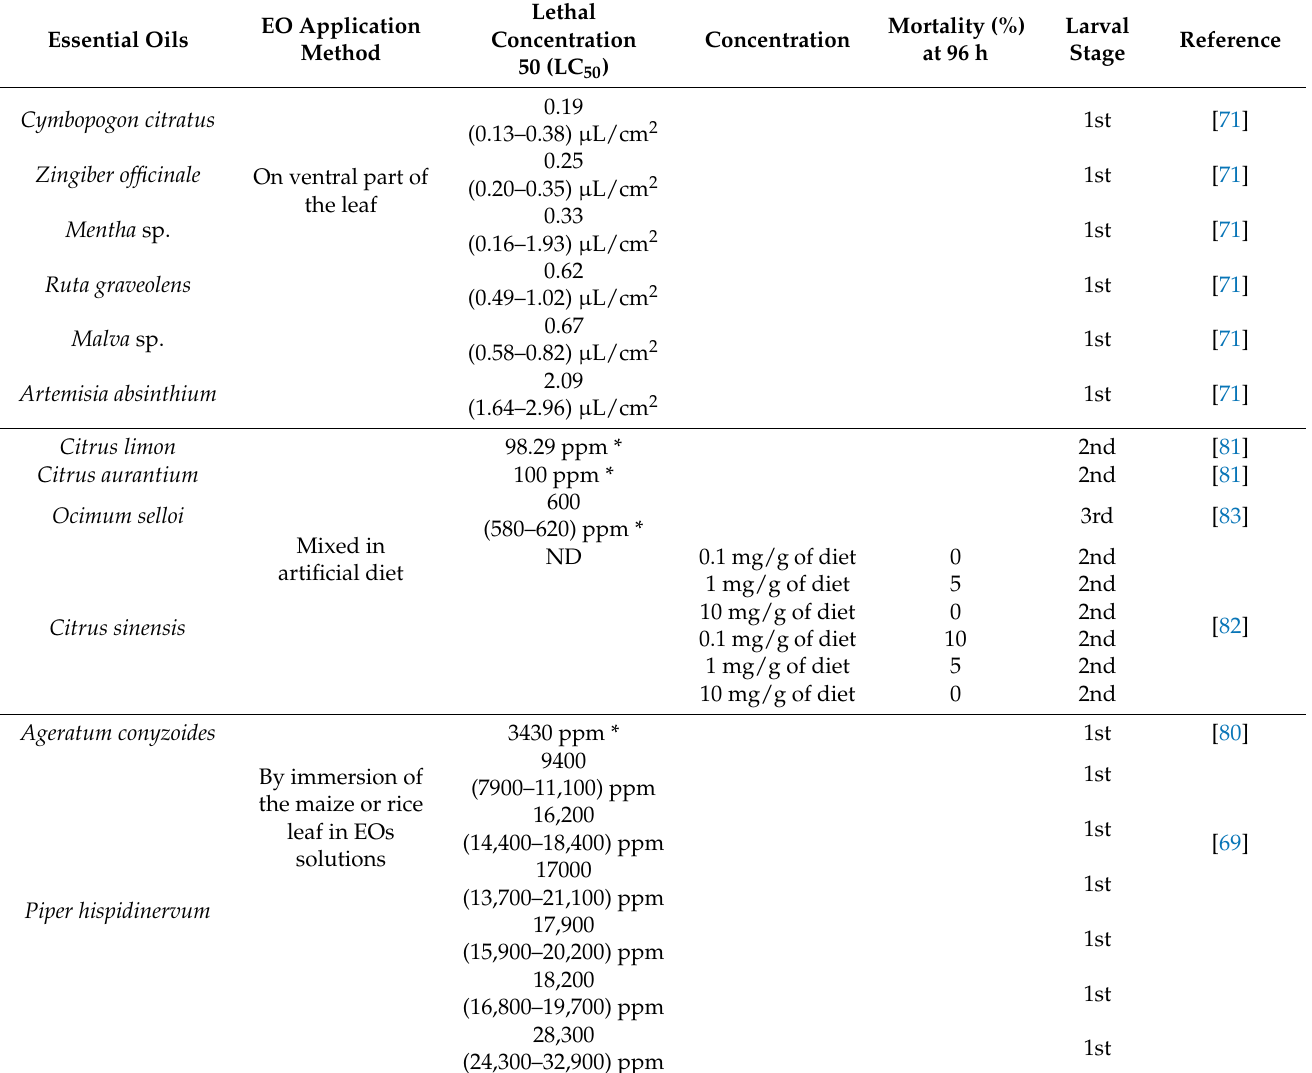
Table 7. Lethal effects of the EOs present in